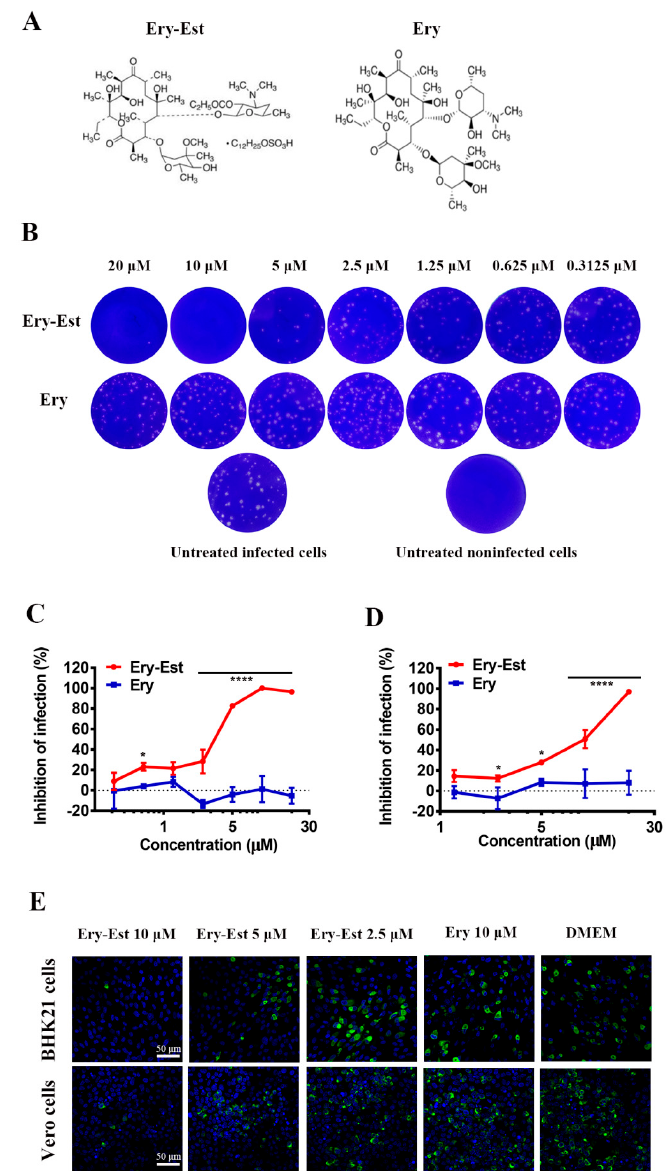
Figure 1. The molecular formula of erythromycin estolate (Ery-Est) and Ery and their inhibitory activity against Zika virus (ZIKV) in di ff erent cell types. ( A ) The molecular formula of Ery-Est and Ery. ( B ) BHK21 cells (2 × 10 6 ) were infected by ZIKV strain SZ01 that were treated with serial concentrations of Ery-Est and Ery, the infected cells were then covered with an overlay of Dulbecco’s modified Eagle’s medium (DMEM) containing 2% fetal bovine serum (FBS) and 1% low meliting-point (LMP) agarose. After incubation for about 5 days, infected cells were stained with 1% crystal violet for plaque visualization and ( C ) the inhibitions of infection were calculated. The experiment was tested in triplicate and data are represented as means ± SD. ( D ) U-251 MG cells (2 × 10 5 ) were infected by ZIKV treated with di ff erent concentrations of Ery-Est and Ery. The percentage of infected cells at 48 h post infection was determined by flow cytometry and normalized to untreated infected cells and the inhibitory percentages were calculated. The experiment was tested in triplicate and data are represented as means ± SD. ( E ) BHK21 and Vero cells (2 × 10 5 ) were infected with ZIKV strain SZ01 and treated by Ery-Est and Ery, then the ZIKV infection was evaluated by immunofluorescence staining after 4 days. ZIKV E protein were stained by mAb 4G2 (green); nuclei were stained by 4,6-diamidino-2-phenylindole (blue), scale bar: 50 µ m. Each experiment was repeated at least twice and similar results were obtained. Statistical analysis: Two-way ANOVA with Sidak’s multiple comparisons for ( C ) and ( D ). * p < 0.05; **** p <